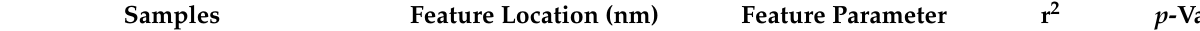
Table 2. r 2 for feature parameters near 1215 nm and 1732 nm. The two quadrats that contained sand only are excluded.